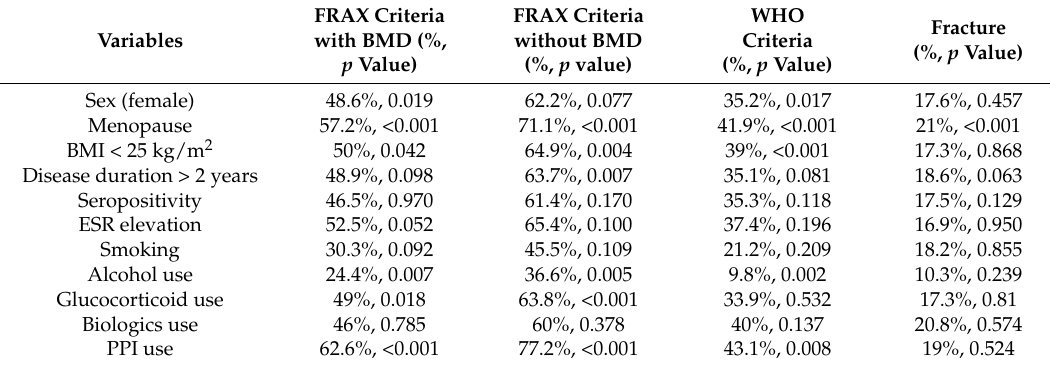
Table 4. Comparison of the frequencies for the high-risk of osteoporotic fractures according to FRAX criteria and WHO osteoporosis